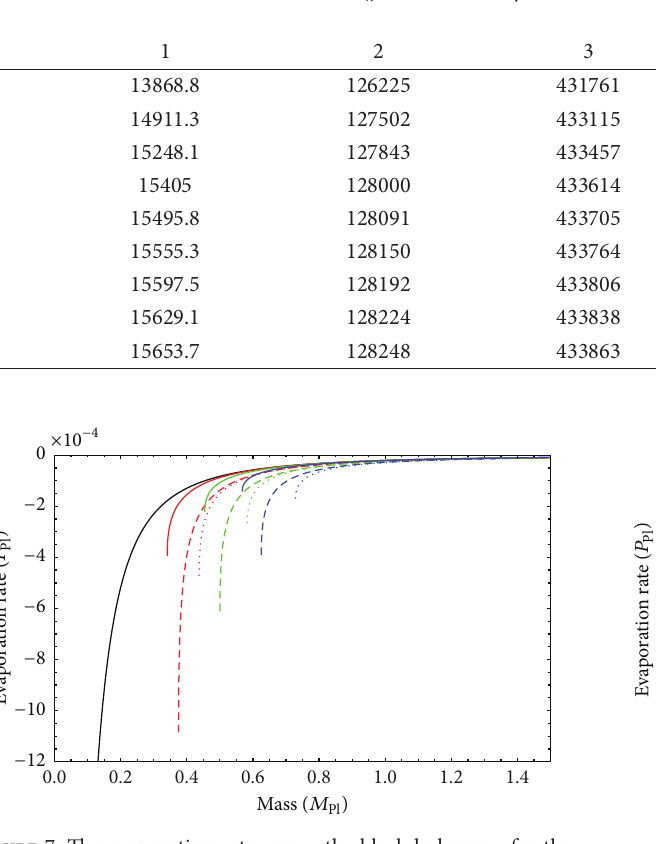
Figure 8: The evaporation rate versus the black hole mass for the case 𝛼 = 1 . Curves are the Hawking result (black), GUP 𝑛 results for 𝑛 = 2 (red), 𝑛 = 5 (green), and 𝑛 = 10 (blue), respectively.